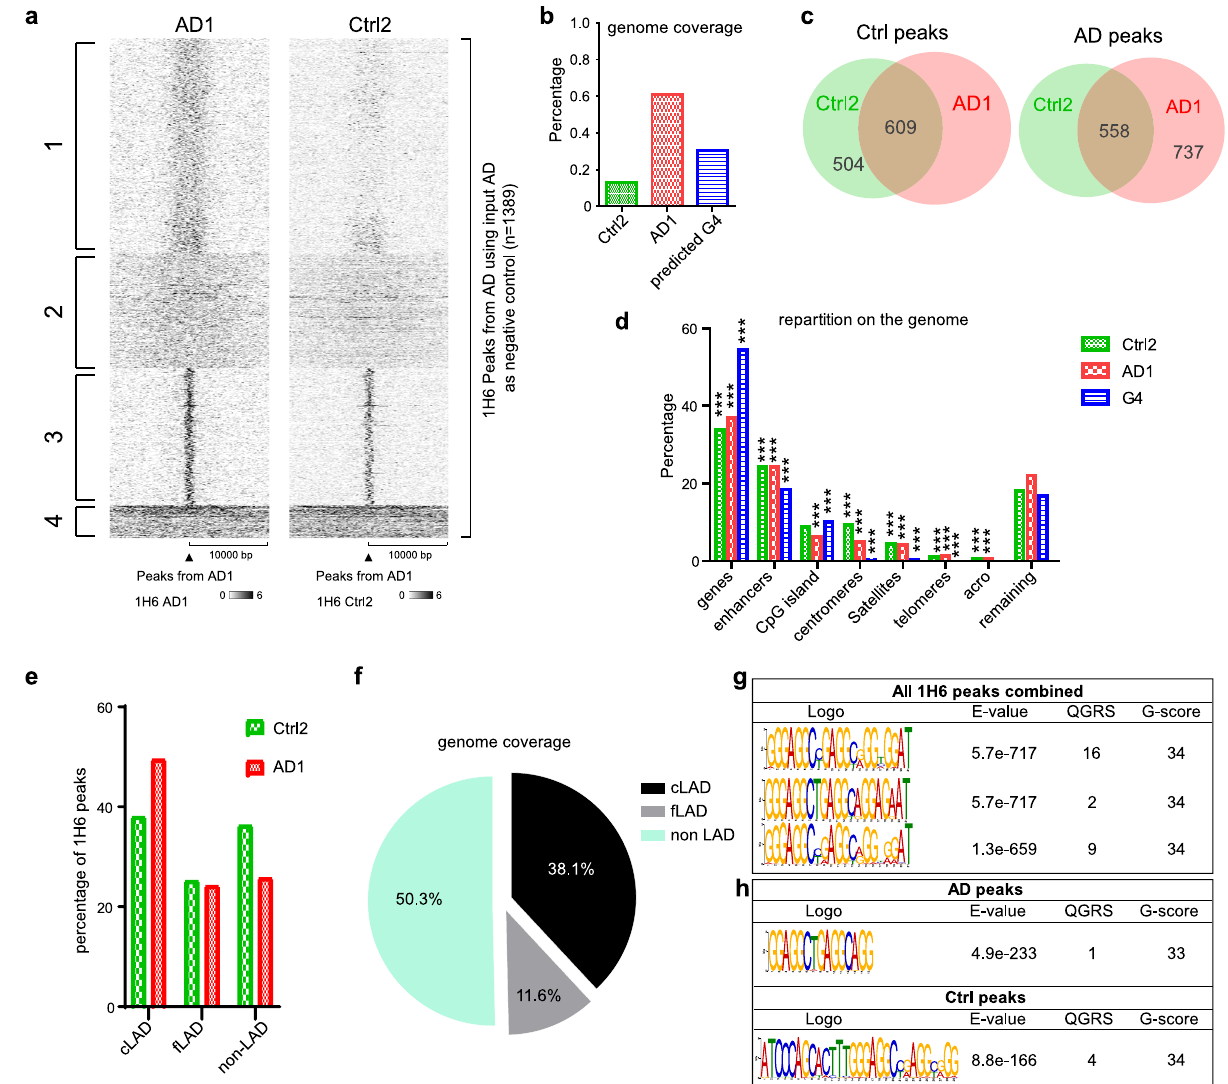
Fig. 3 1H6 peaks present high similarities with canonical and non-canonical G4 sequences. a Heatmap of 1H6 ChIP-seq enrichment from AD1 neurons or control neurons (Ctrl2) centered on AD1 peaks with a ±10 Kbp. K-means clustering highlighted on the right was done using the AD1 enrichment. b Histogram showing the percentage coverage of 1H6 peaks and predicted G4 sequences on the entire human genome. c Venn diagram shows the number of AD1 peaks that are speci fi c and those that are shared with a Ctrl2 peak and a diagram that shows the Ctrl2 peaks that are speci fi c and those that are shared with an AD1 peak. d Repartition of 1H6 peaks and predicted G4 sequences on the genome. A permutation test was performed for each combination in order to calculate the signi fi cance. A total of 1000 permutated sets of probes were randomly generated and annotated for the different parts of the genome. e Graph showing the percentage of colocalization between 1H6 peaks and LAD or non-LAD. f A pie chart showing the repartition of the genome between LAD and non-LAD. g MEME analysis on all the ChIP-seq combined on the neurons showing the top three motifs E value associated with them, the number of QGRS (quadruplex forming G-rich sequences), and the highest G score associated with these sequences. h MEME analysis on the 1H6 peaks of Ctrl2 or AD1 neurons showing motifs that can form a G4 structure with the E value associated with them, the number of QGRS, and the highest G score associated with these